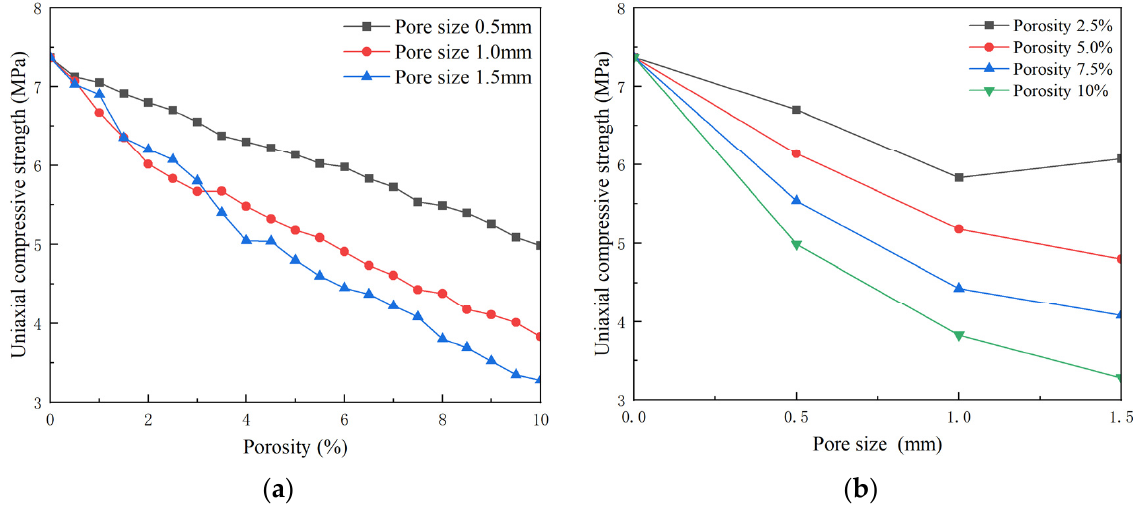
Figure 5. Variation curve of compressive strength of specimens under different pore characteristics. ( a ) Uniaxial compressive strength-porosity relationship diagram; ( b ) Uniaxial compressive strength-pore size relationship diagram.